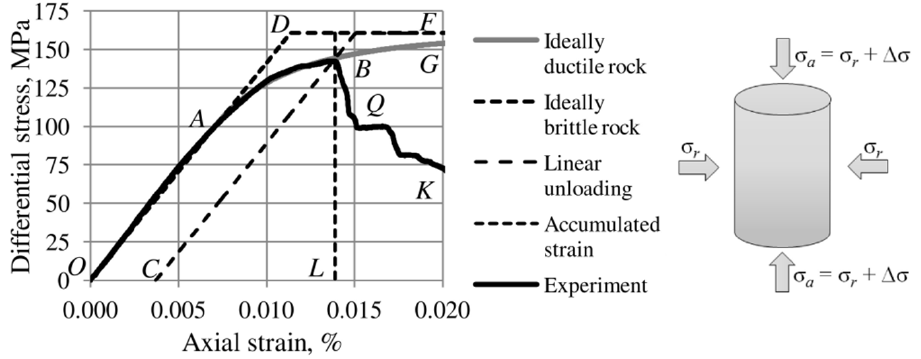
Figure 3. Typical single-stage loading test result for brittleness index determination. Modified after Ezhov et al., 2021 [27].